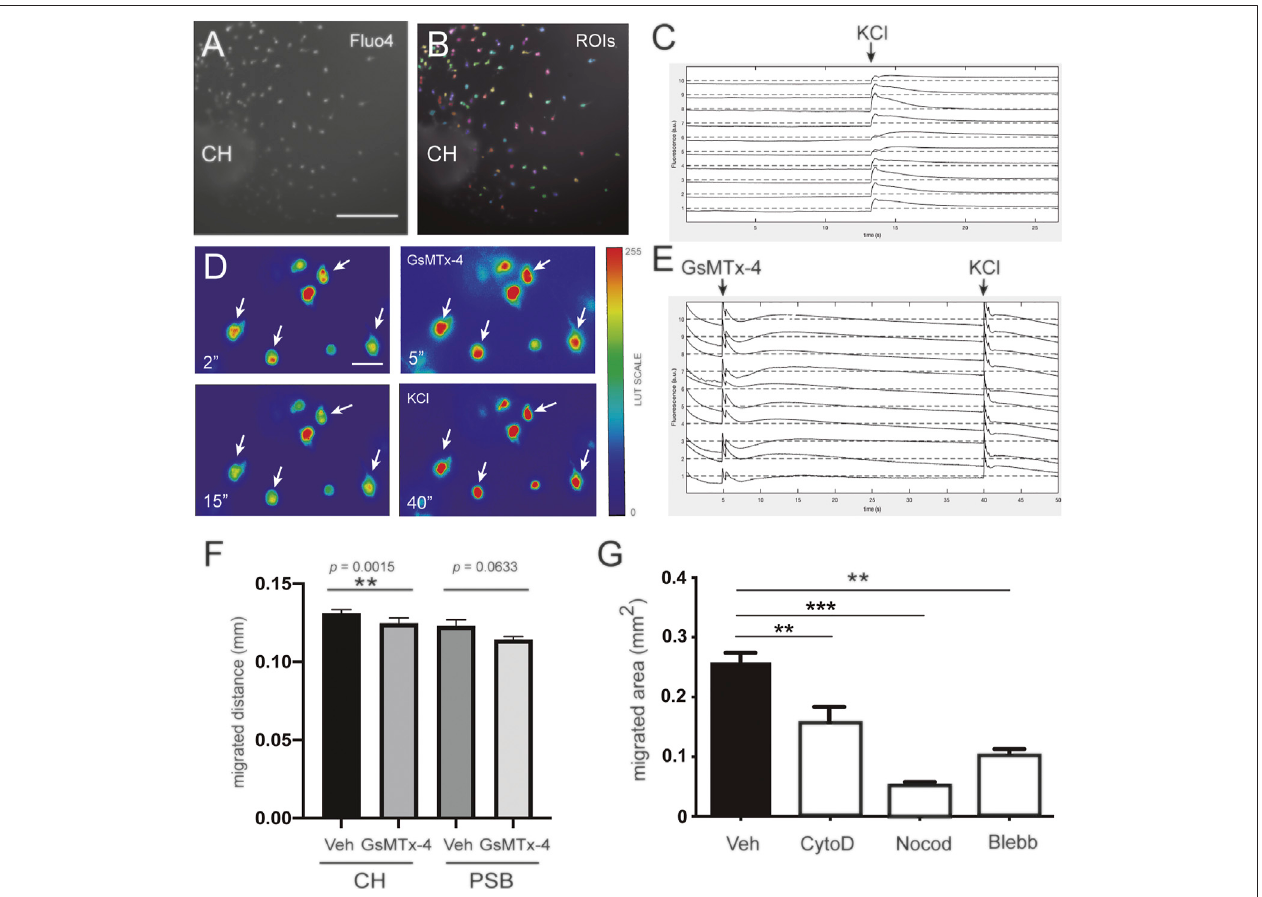
FIGURE3| InvolvementofmechanosensoryreceptorsinthemigrationofCH-derivedCRcells (A – C) Fluorescentcalciumimagingexperimentsdemonstratingthat CR cells are able to depolarize in the presence of KCl. The images in panel A corresponds to representative neuronal cultures of CH on methylcellulose-containing medium (A) . The same image is shown in panel B together with the detected regions of interest (ROIs, colored patches) and that ascribed as neuron (B) . (C) The application of 0.1 M KCl is indicated with an arrow. The abrupt increase in fl uorescence reveals neuronal response to the chemical stimulation. (D) Fluorescence images at preset time points (2, 5, 15, and 40 s) from identi fi ed CR cells illustrating the changes in Ca 2+ upon application of GsMTx4 (at 5 s) and KCl (at 40 s). Images wereextracted from the Supplementary Material MovieS3 ).Fluorescence images werecoloreditedtovisuallyenhance the transient decrease in Ca 2+ after GsMTx4 (at 5 s) and KCl (at 40 s). White arrows help identifying the fl uorescence evolution of four neurons (E) Fluorescent traces for 10 representative neurons upon treatment with GsMTx4 (at 5 s) and KCl (at 40 s), highlighting their strong response to stimulation (F) Bar plots comparing the effect of GsMTx4 treatment on the migration of CH- and PSB-derived CR cells, and relative to untreated, control cells. CR cells exhibit a larger migration distance as compared to PSB ones (G) Bar plots comparing the migration capacity of control CR cells with those treated with cell-mobility blockers, namely cytochalasin D, Nocodazole, and Blebbistatin. For panels (F,G) , data are presented as mean ± s.e.m.. Veh: Vehicle; CytoD: Cytochalasin D; Noco: Nocodazole; Bleb: Blebbistatin; CH: cortical hem; PSB: pallium subpallium boundary. The speci fi c p values are included in (F) , and ** p < 0.01 and *** p < 0.001 in (F,G) , respectively. Scale bar A = 300 μ m pertains to B; D = 50 μ